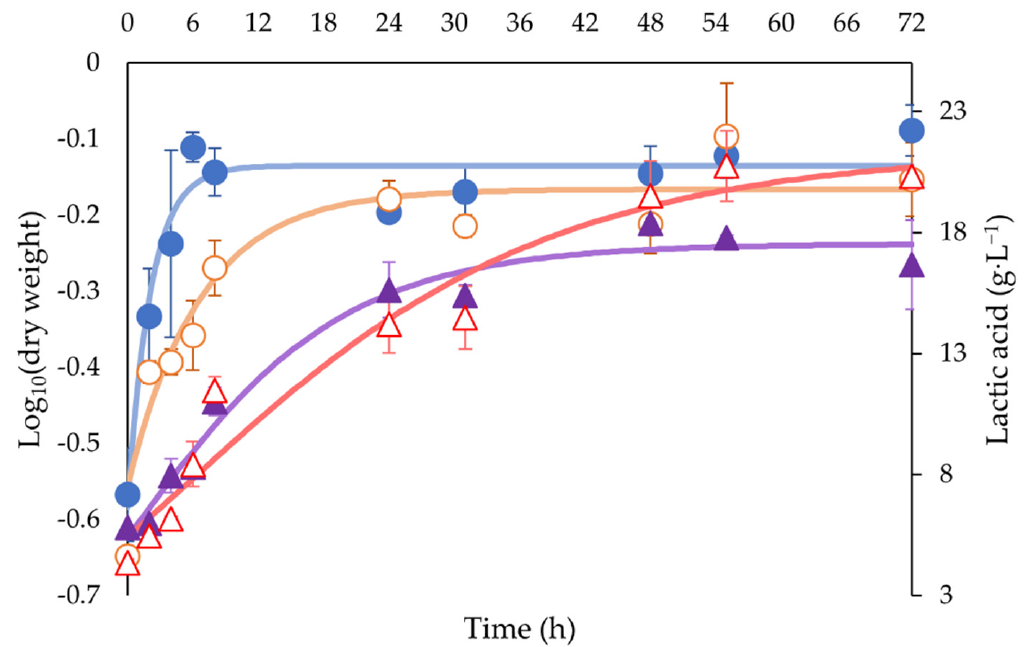
Figure 1. Log 10 (dry weight) and lactic acid concentration for each strain during lactic acid fermen- tation. ● Dry weight for COM, ○ Dry weight for WIL, ▲ Lactic acid for COM, ∆ Lactic acid for WIL. Abbreviations: WIL, L. plantarum wild strain; COM, L. plantarum commercial strain.